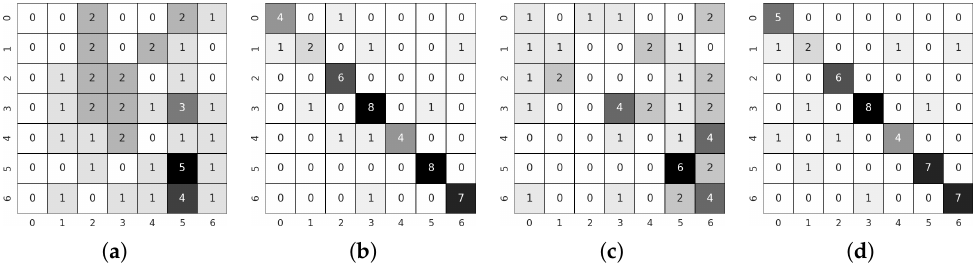
Figure 20. Different view test. ( a , b ): ResNet3D model, using RGB and MBEVs, respectively. ( c , d ): X3D model, using RGB and MBEVs, respectively. Dataset: KITTI360, test-split, 48 total